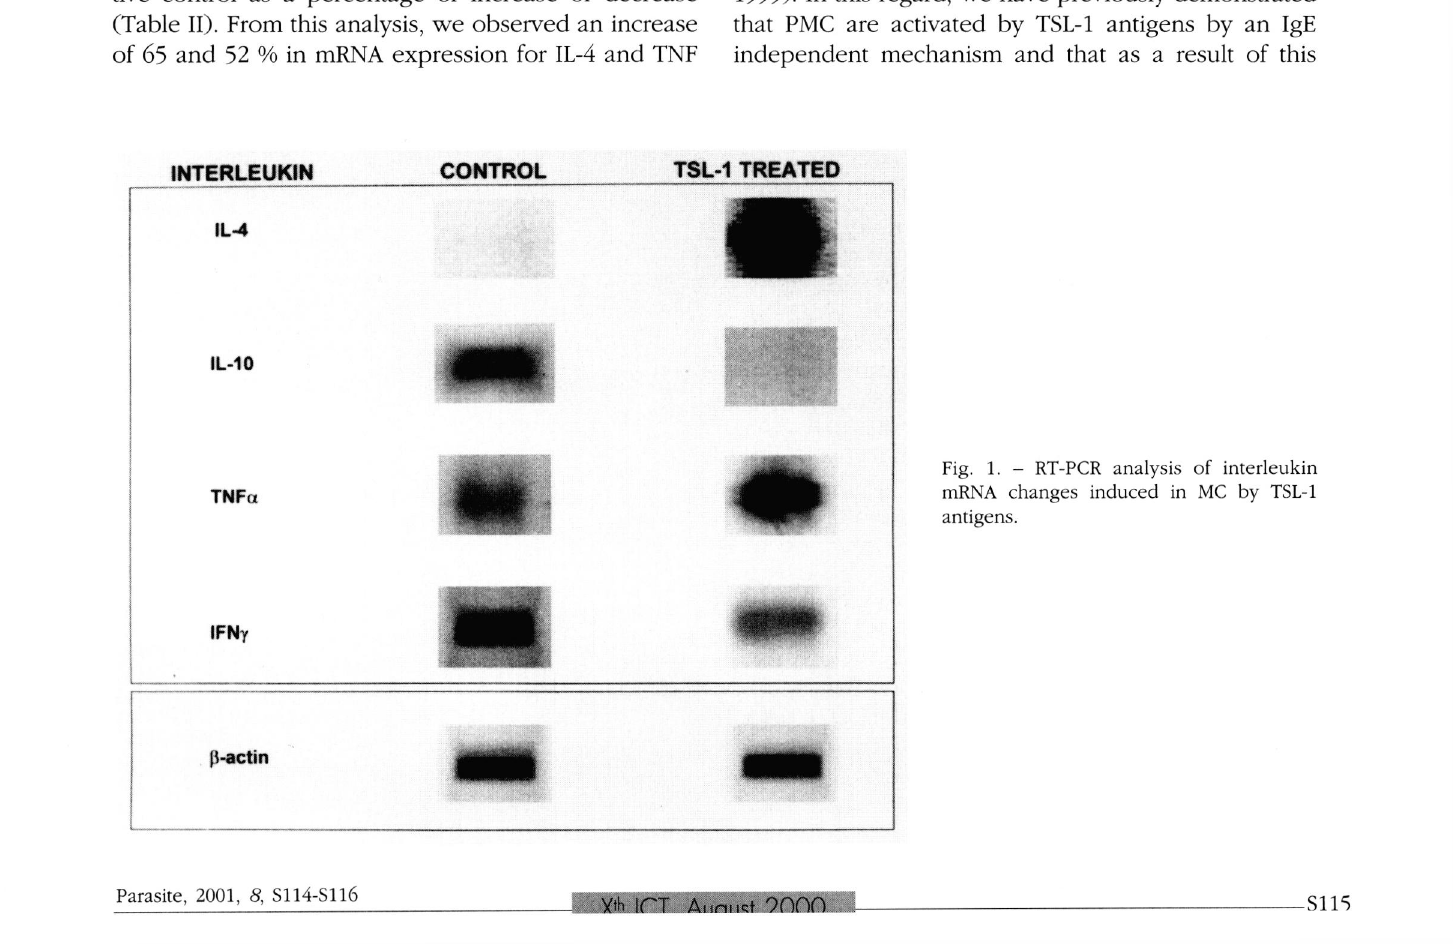
United Kingdom) and relative values were determined